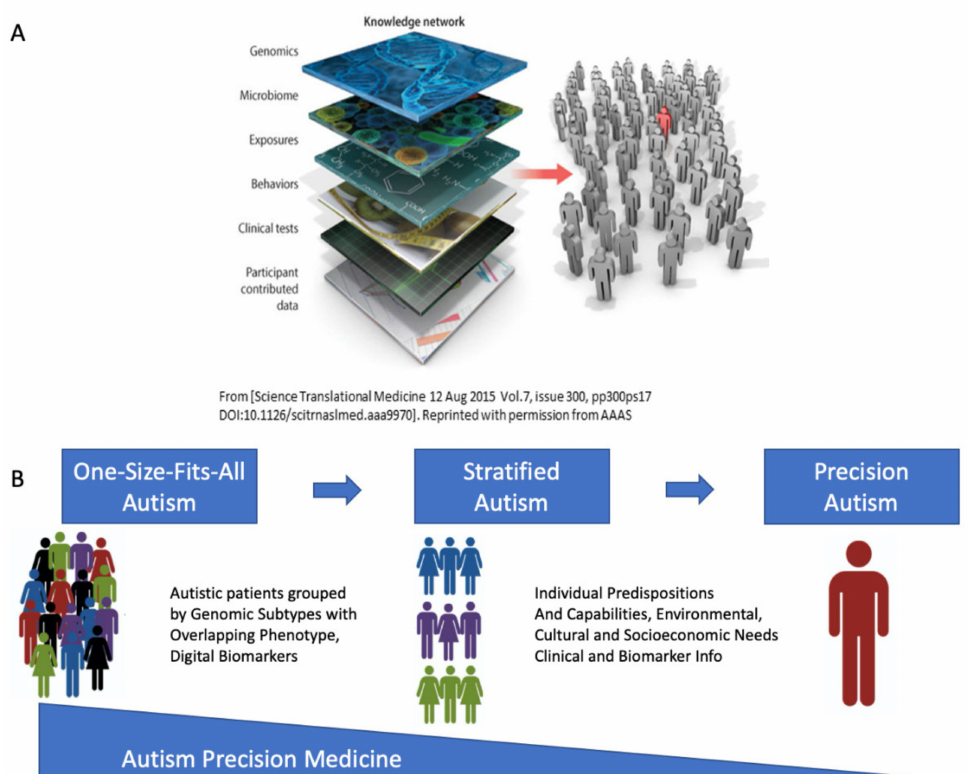
Figure 1. Leveraging existing genomic data to stratify the broad Autism Spectrum. ( A ) Reprinted with permission from AAAS Science Translational Medicine 12 August 2015 Vol. 7, Issue 300, pp300ps17 [33], Copyright AAAS 2015. The Precision Medicine model aims at the design of